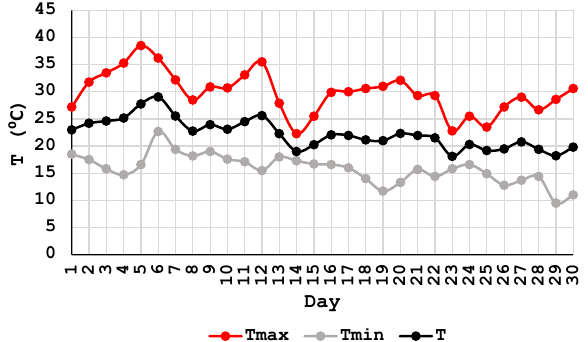
Figure 5. Daily air temperature.